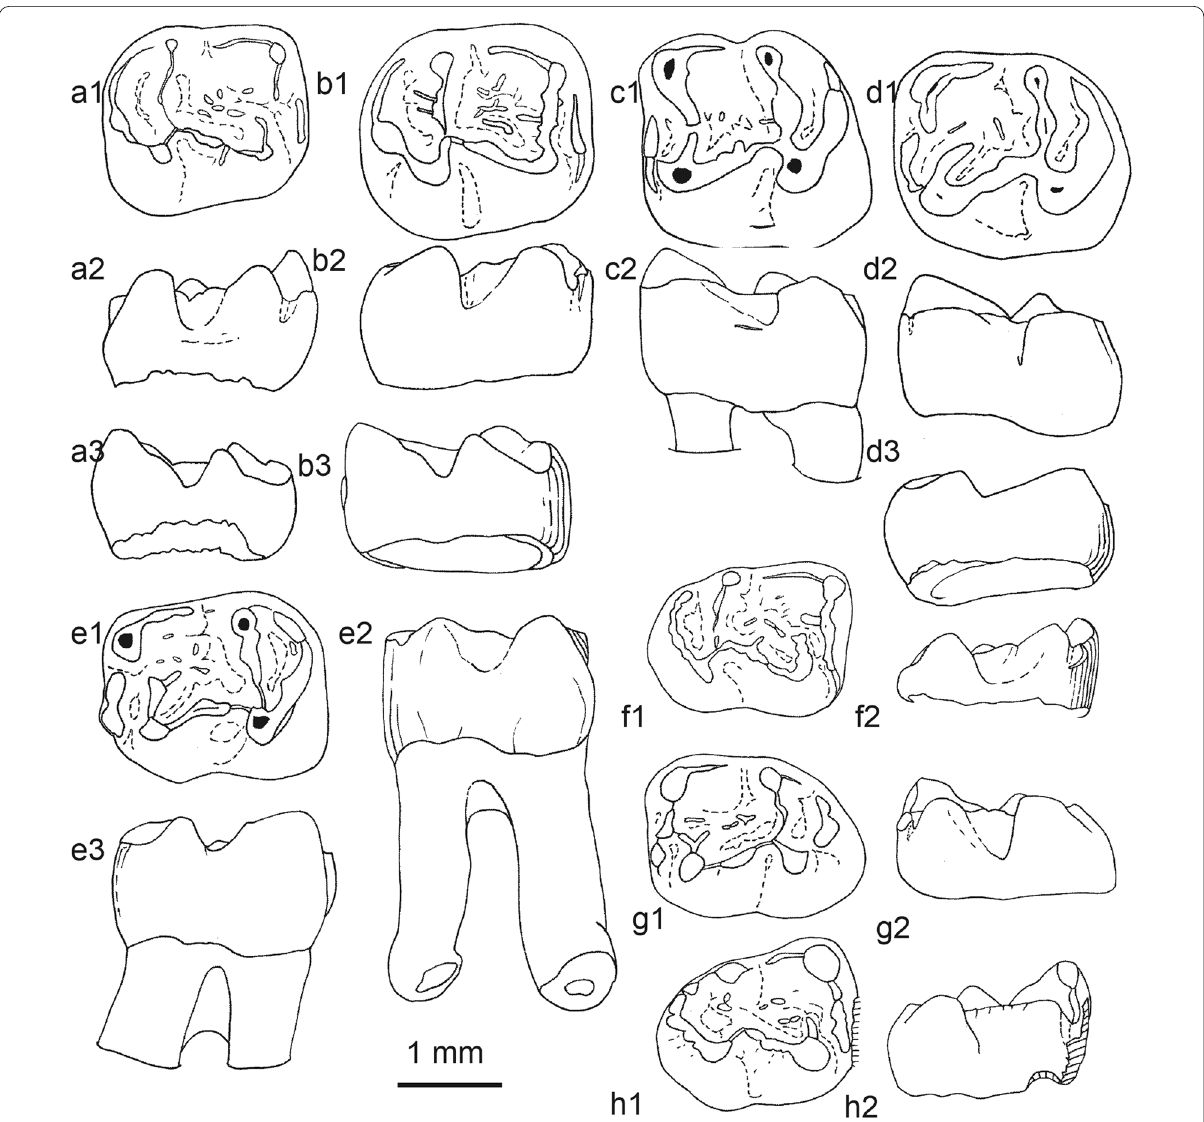
Fig. 26 Lower molars of Protadelomys lugdunensis Hartenberger, 1969, from Laprade (Quercy), a LAP 89, right m1; a1, occlusal view; a2, buccal aspect; a3, lingual aspect. b LAP 249, right m2; b1, occlusal view; b2, buccal aspect; b3, lingual aspect. c : LAP 263, left m2; c1, occlusal view; c2, buccal aspect. d LAP 221, left m2; d1, occlusal view; d2, buccal aspect; d3, lingual aspect. e LAP 87, left m1; e1, occlusal view; e2, buccal aspect; e3, lingual aspect. f LAP 253, right m3; f1, occlusal view; f2, buccal aspect. g LAP 233, left m3; g1, occlusal view; g2, buccal aspect. h LAP 252, right m3; h1, occlusal view; h2, buccal aspect. Scale bar 1 =